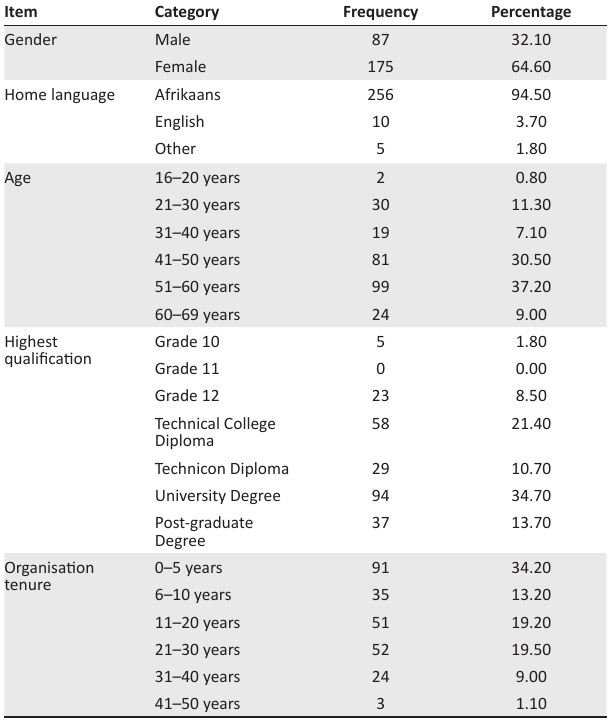
TABLE 1: Characteristics of participants.